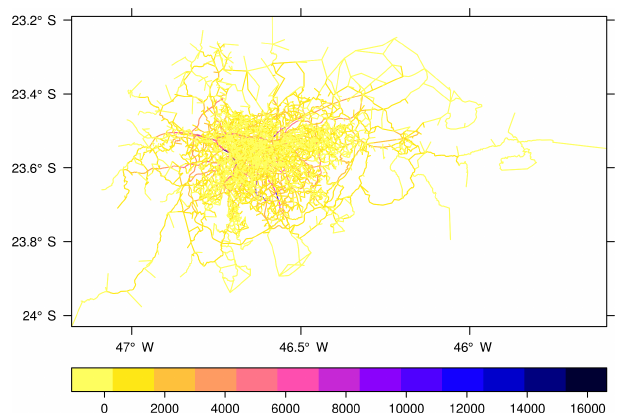
Figure 2. Traffic flow simulation for LDV (vehh − 1 ) at 08:00– 09:00LT for